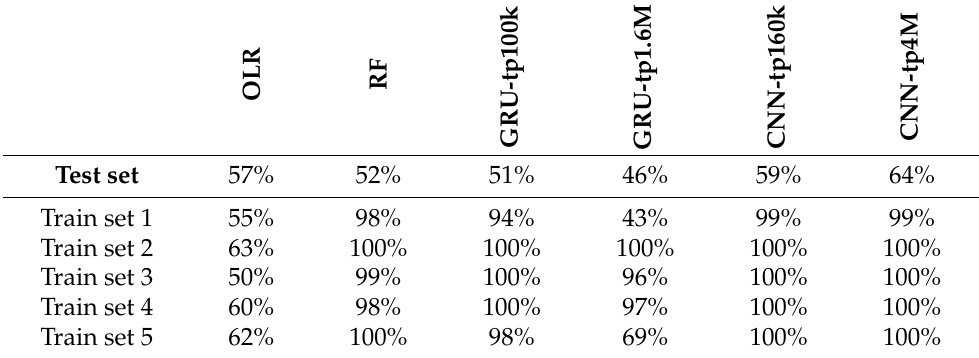
Table 7. Overall exact accuracy of classification: comparison of results on the testing set and training